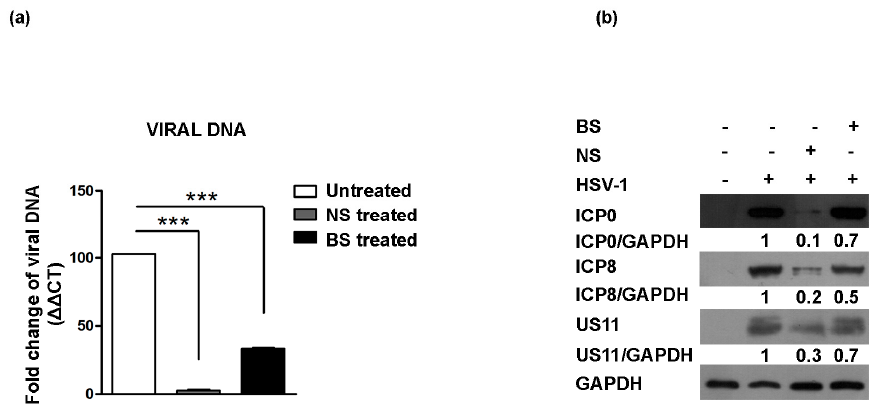
Figure 4. Effect of almond extracts treatment on the HSV-1 replication and on viral antigens’ expression. ( a ) The viral DNA was extracted from Vero cells 24 h post-HSV-1 infection as described in the Materials and Methods. Relative quantization of viral DNA was performed using real-time quantitative PCR and analyzed by the comparative C t method ( ∆∆ C t ). Values represent ± SD of the average of three samples normalized against the GAPDH copies number; ( b ) Immunoblot analysis was performed in Vero cells HSV-1 infected and treated with natural (NS) and blanched (BS) skin extracts (0.4 mg/mL). Equal amounts of proteins were separated by polyacrylamide gel electrophoresis, transferred and probed with specific antibody to α (ICP0), β (ICP8) and γ (US11) viral proteins. GAPDH proteins were used for housekeeping. Band density was determined with the T.I.N.A. program and was expressed as the fold change over the appropriate housekeeping genes. Asterisks (***) indicate significant changes of p -values less than